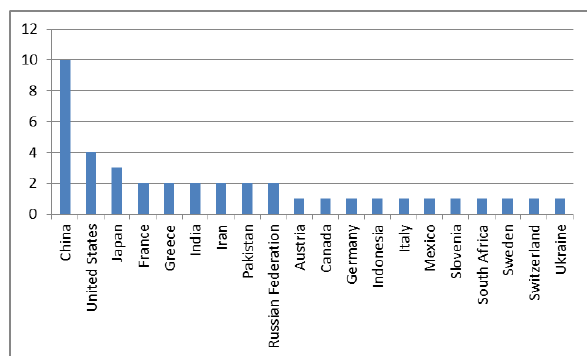
Figure 1. Number of papers by country.